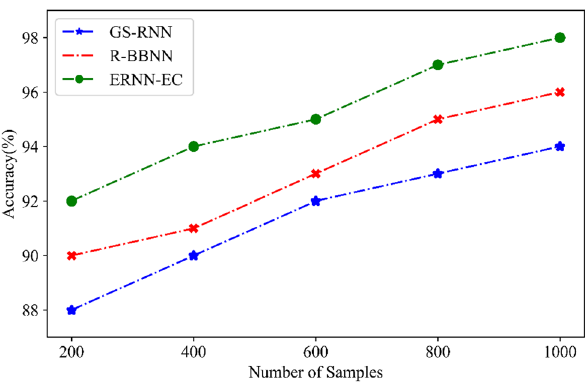
Figure 3: Comparison of accuracy.